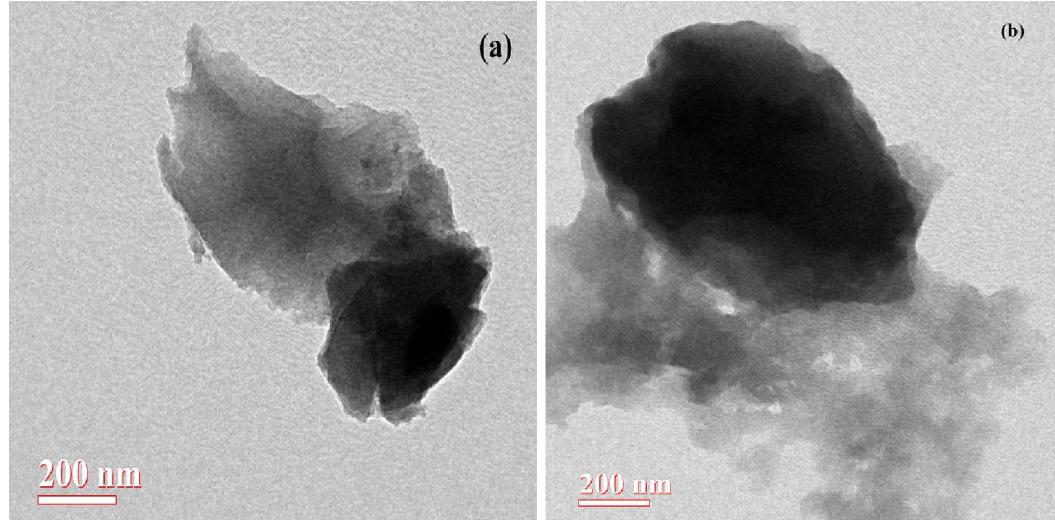
Figure 3. TEM images of the catalysts ( a ) AAC-CC ( b ) AC-CC 34 .